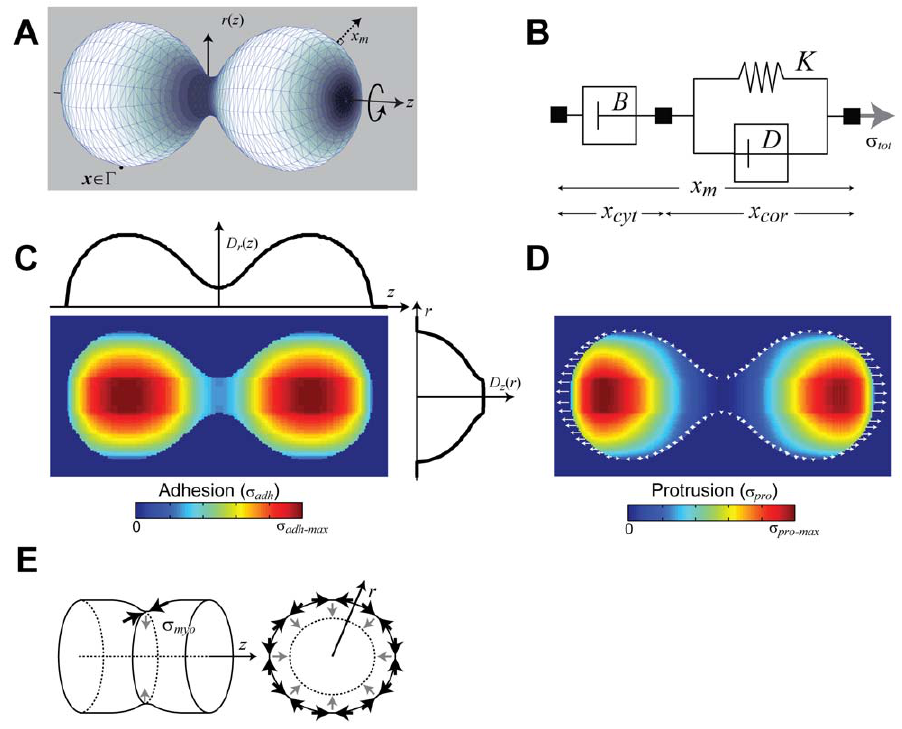
Figure 1. Level set model geometry and stress distribution. A. The cell model assumes cylindrical symmetry. Points on the cell boundary ( x M C ) are obtained implicitly. B. Using a viscoelastic description of the cell (Equation 3), cell boundary/membrane displacements ( x m ) are generated by moving the potential function ( w , not shown) according to the total stress applied, s tot (Equation 4). The spring-dashpot ( K , D ) elements represent the mostly elastic cortex, which moves a distance x cor . The viscous component ( B ) represents the cytosol, which moves a distance x cyt . Values for K , B and D were previously obtained using micropipette aspiration experiments and are given in Table 2. C. Area density maps ( D r ( z ) and D z ( r )), obtained by summing the cell area (in the z-r plane) one axis at a time (Equation 5). The resultant adhesion map, shown overlaid on the cell shape, is obtained by multiplying these two together. D. Protrusive stress is assume to work in the z -direction away from the furrow according to Equation 7, but only the component normal to the boundary is used. E. Geometry of contractile stress. Though myosin II acts radially, its effect is to reduce the circumference, and hence radius. This can be recreated by applying a stress ( s myo ) inwards radially (shown in gray).